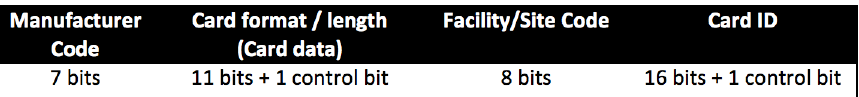
Figure 16. Data structure of an HID Proximity card.